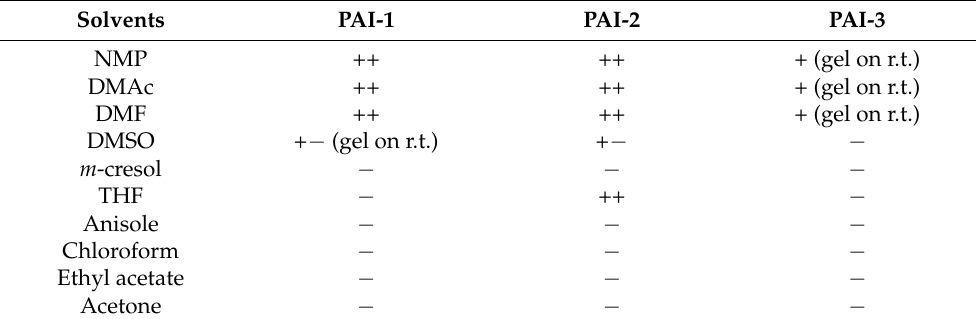
Table 1. Solubility of the PAIs.